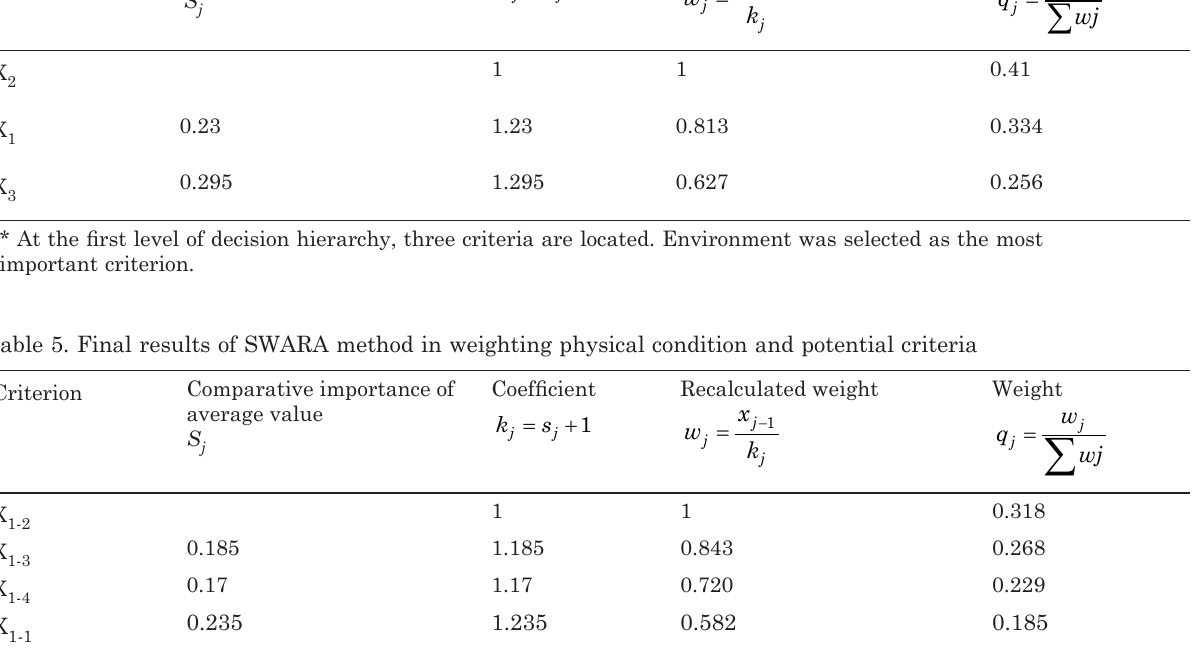
Table 4. Final results of SWARA method in weighting criteria Criterion